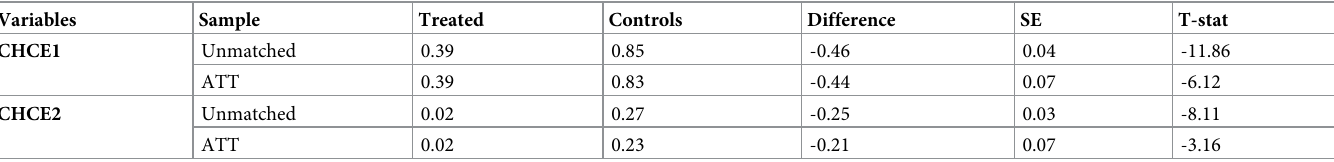
Table 4. ATT on insured and uninsured households by total household expenditure and non-food measures in Kutaber district, Ethiopia, 2020 (n = 472). Variables